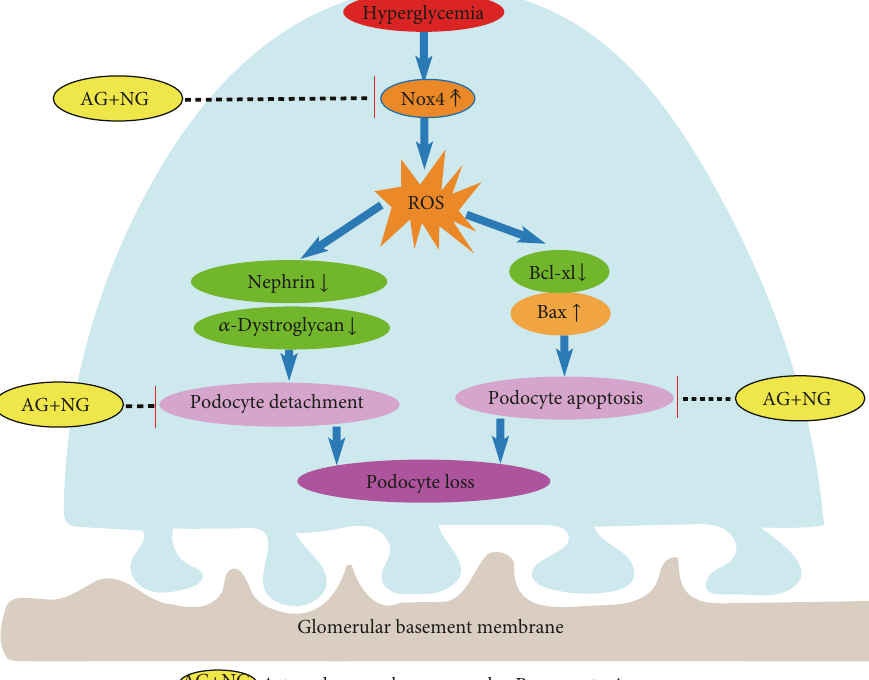
Figure 8: Graphic representation of the potential protection mechanism of AG plus NG on podocyte injury in diabetic